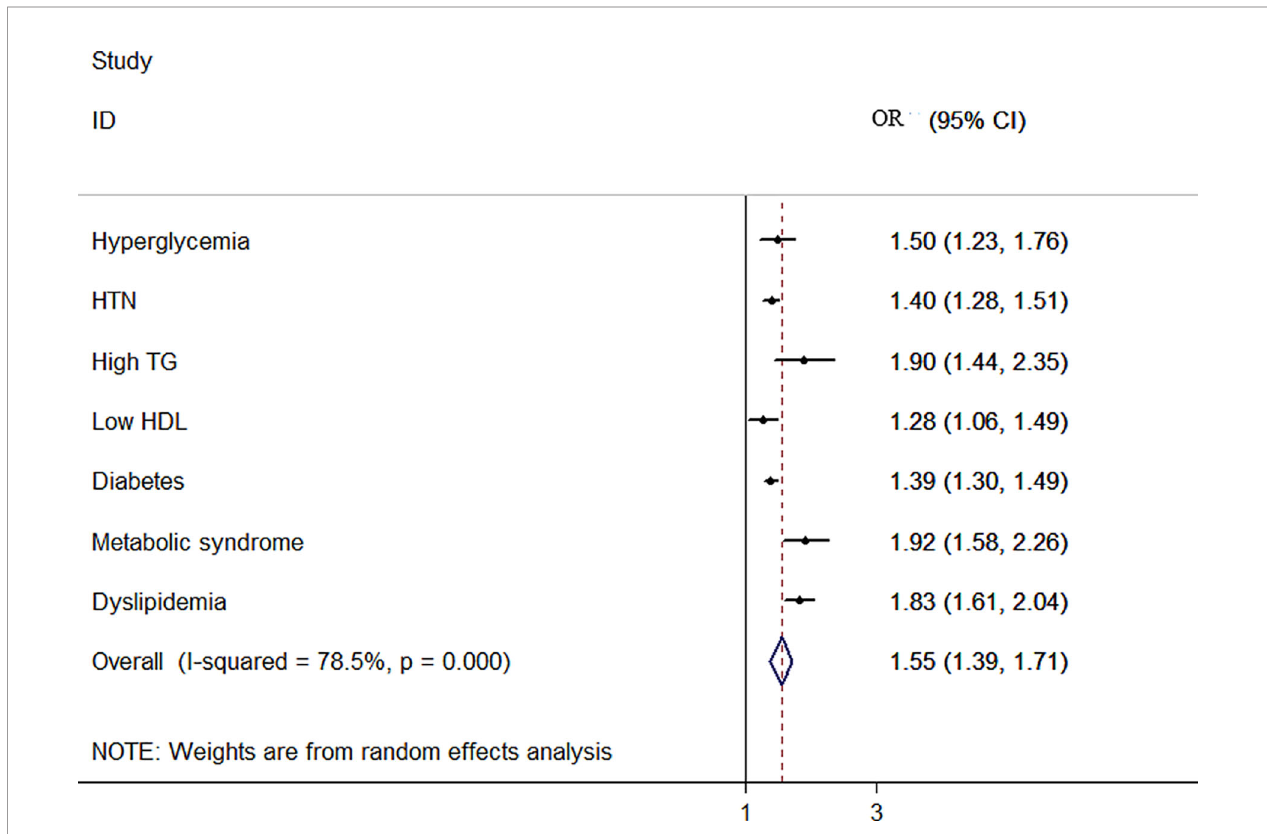
FIGURE 2 | Forest plot detailing the pooled association between NWO with